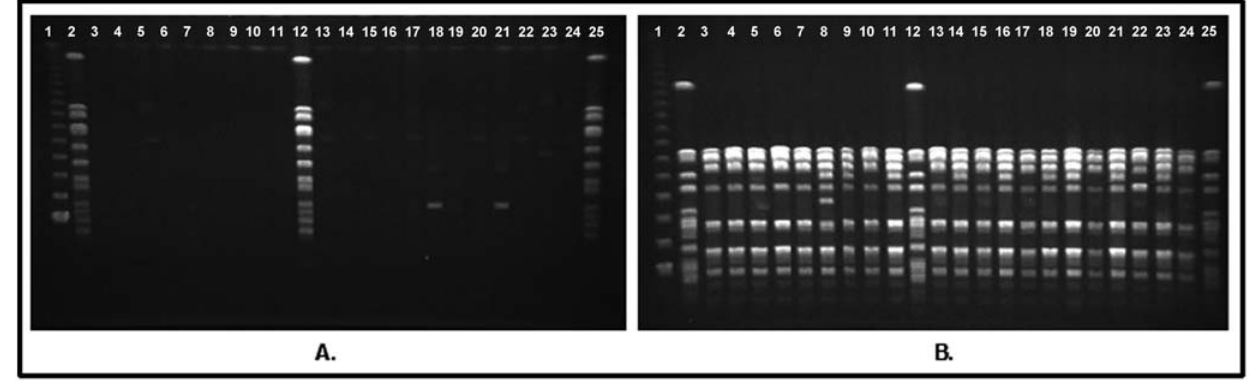
Figure 2. A: PFGE of MRSA isolates from swine and swine workers; DNA digested with Sma I. B: PFGE of MRSA isolates from swine and swine workers; DNA digested with Eag I. Lane 1: molecular weight ladder. Lanes 2, 12, 25: NCTC 8325 (control strain). Lanes 3–11: isolates from swine workers. Lanes 13–24: isolates from swine.